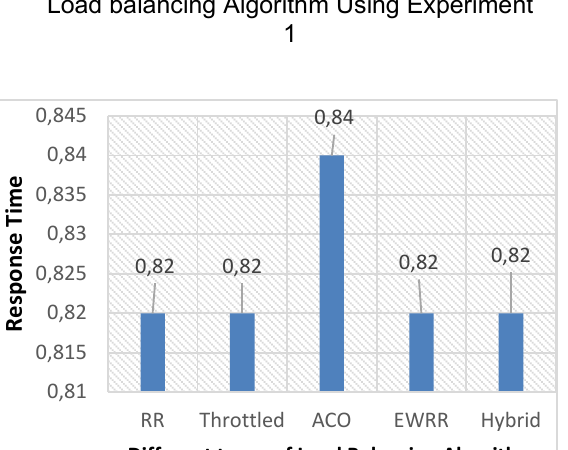
Table 4. Experiment 2 User Base configuration